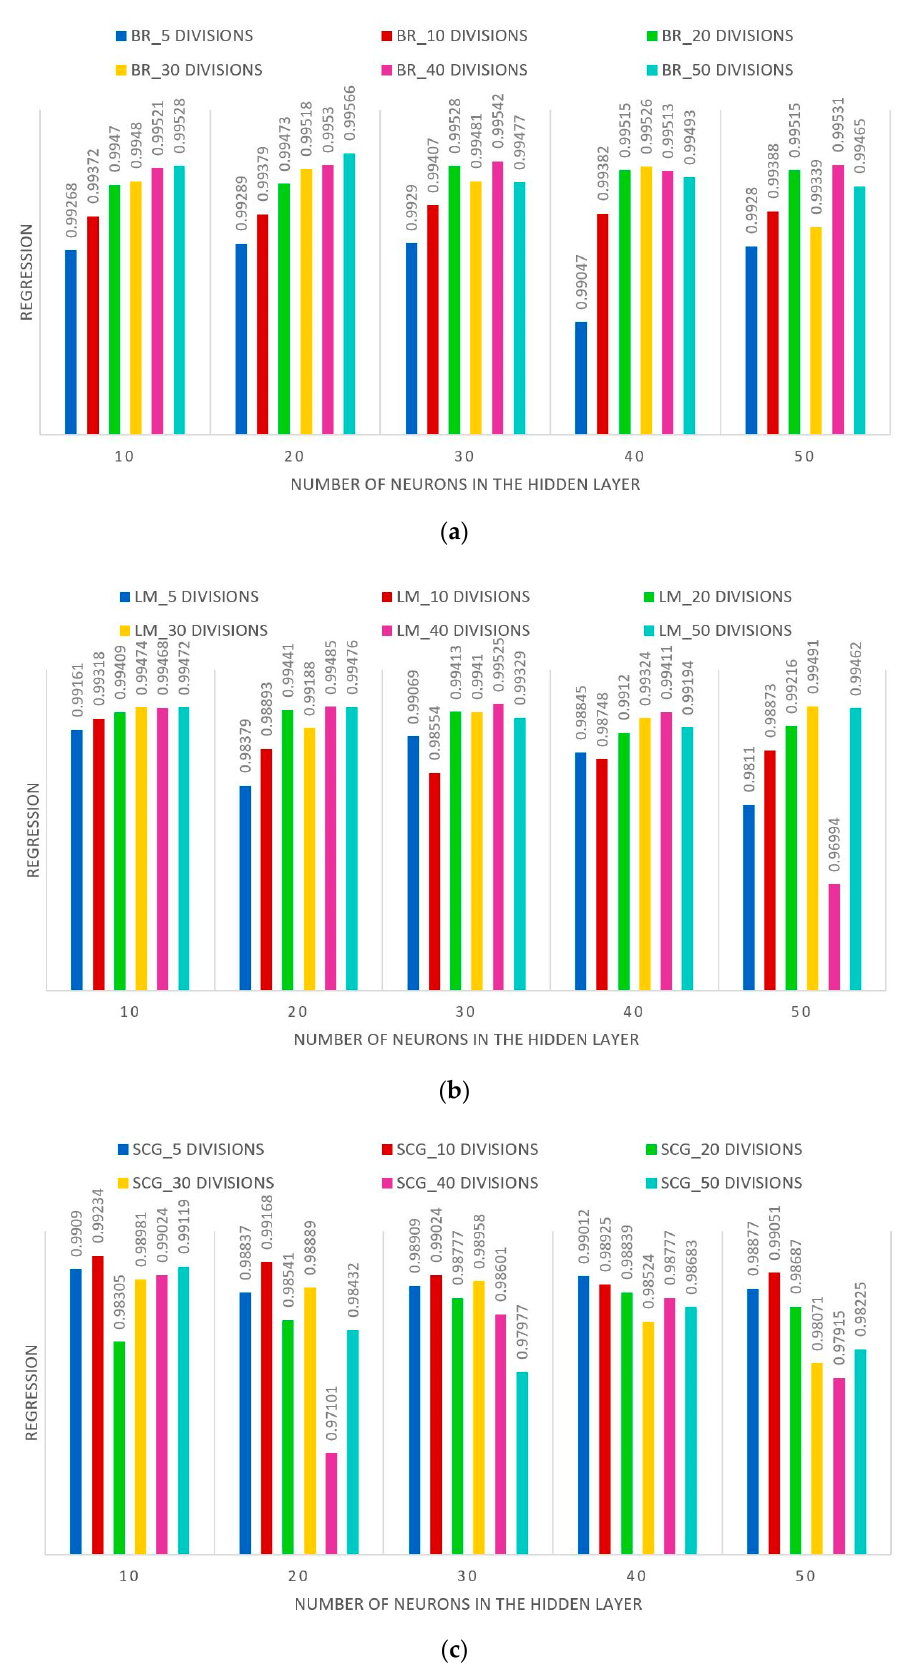
Figure 13. ANN sensitivity of the different models designed for the training type: ( a ) BR, ( b ) LM, and ( c )